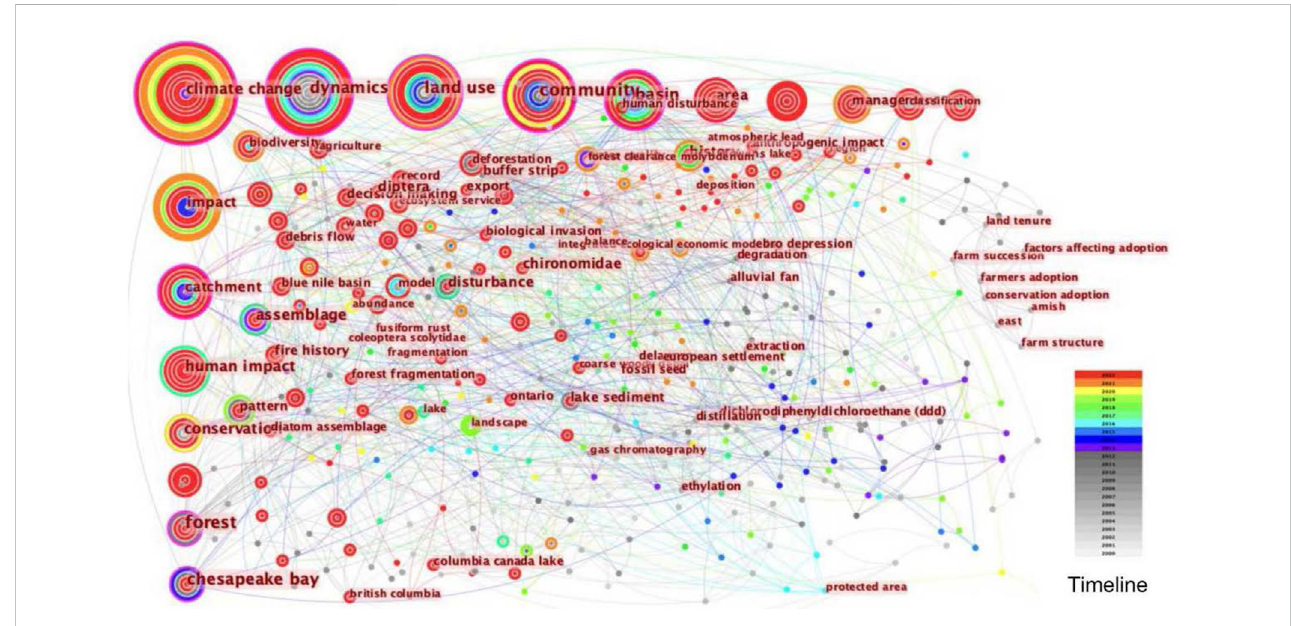
FIGURE 2 Research progress of foreign human settlement in watershed